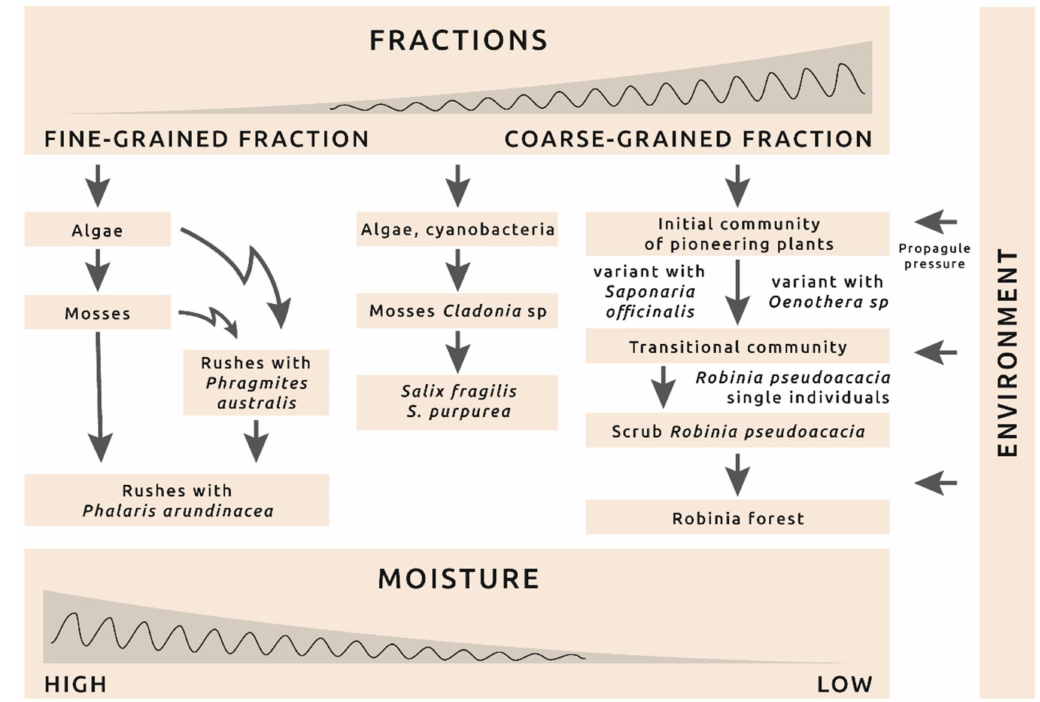
Figure 4. Model of succession: directions and phases of vegetation development in the vicinity of the “W ó jcice”